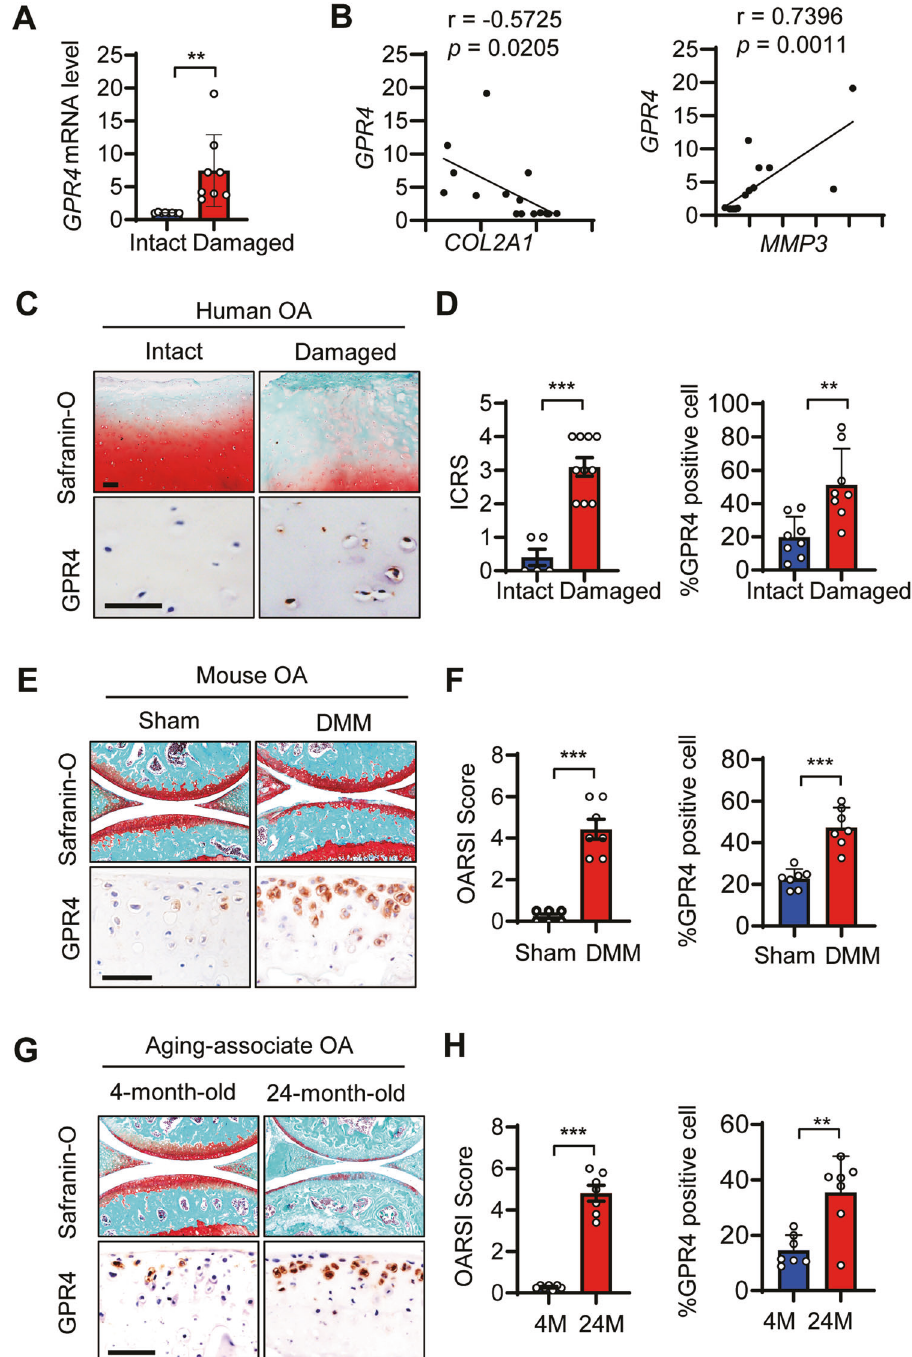
Fig. 1 GPR4 expression was upregulated in human and mouse OA articular cartilage. A The mRNA levels of GPR4 in intact and damaged regions of articular cartilage from OA patients ( n = 8) were determined by qRT-PCR. Data are expressed as mean ± s.d. ** p < 0.01 by Student ’ s two-tailed t test. B Correlation between the expression of GPR4 and COL2A1 (left), or MMP3 (right) in intact and damaged regions of articular cartilage from OA patients ( n = 8) by qRT-PCR. Pearson ’ s correlation analysis was performed. C , D Representative images of Safranin-O staining and immunohistochemistry (IHC) staining of GPR4 in intact and damaged regions of articular cartilage from human OA patients ( C ), Scale bar, 50 μ m ( n = 8 patients per group). International Cartilage Repair Society (ICRS) scores of human OA cartilage were analyzed ( D , left) and GPR4 positive cells were quanti fi ed by IHC ( D , right). n = 8. Data are expressed as mean ± s.d. ** p < 0.01, *** p < 0.001 by Student ’ s two-tailed t test. E – H Staining of articular cartilage sections with Safranin-O and GPR4 IHC from sham-operated ( n = 6) or DMM-operated ( n = 7) mice ( E ) or 4- or 24-month-old mice ( n = 7). Scale bars, 50 μ m. G The corresponding OARSI (Osteoarthritis Research Society International) scores were assessed ( F and H , left) and GPR4 expression was quanti fi ed ( F and H , right), respectively. n = 7. Data are expressed as mean ± s.d. ** p < 0.01, *** p < 0.001 by Student ’ s two-tailed t